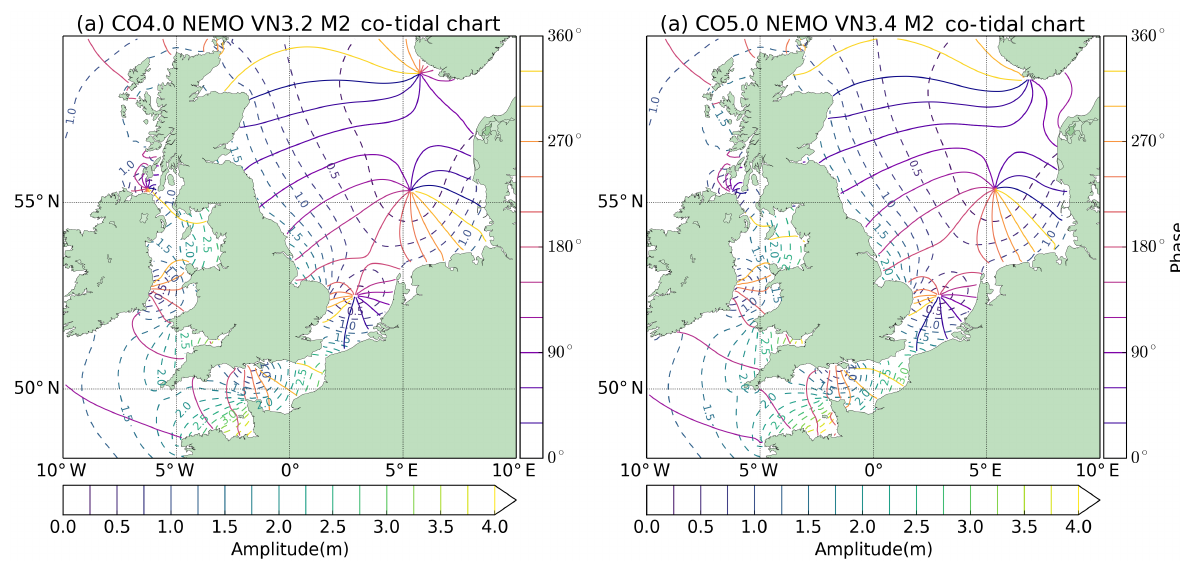
Figure 5. M2 co-tidal charts. (a) CO4, NEMO v3.2. (b) CO5, NEMO v3.4.